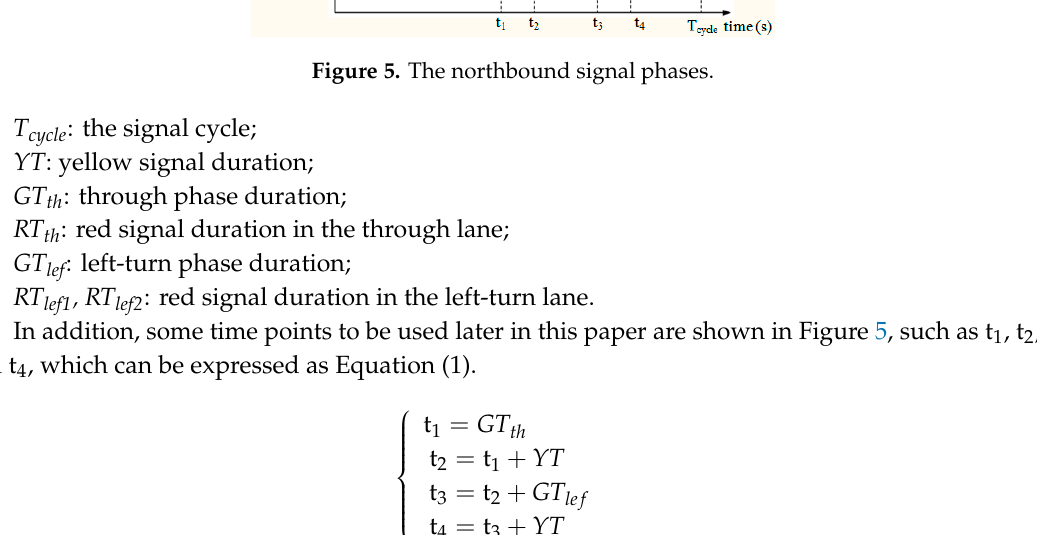
Figure 5. The northbound signal phases.